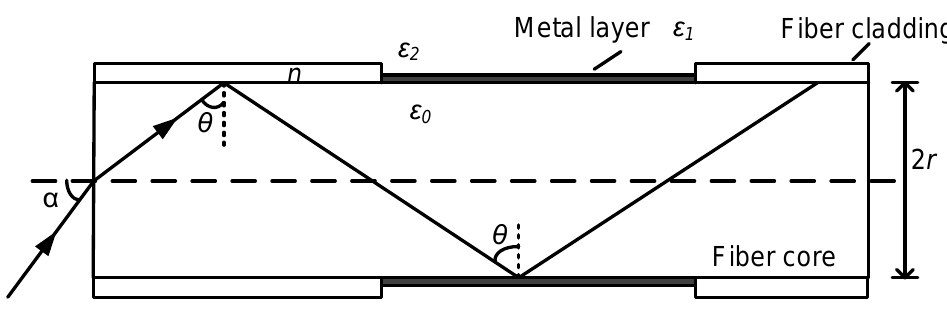
Figure 1. Light transmission mode in an optical